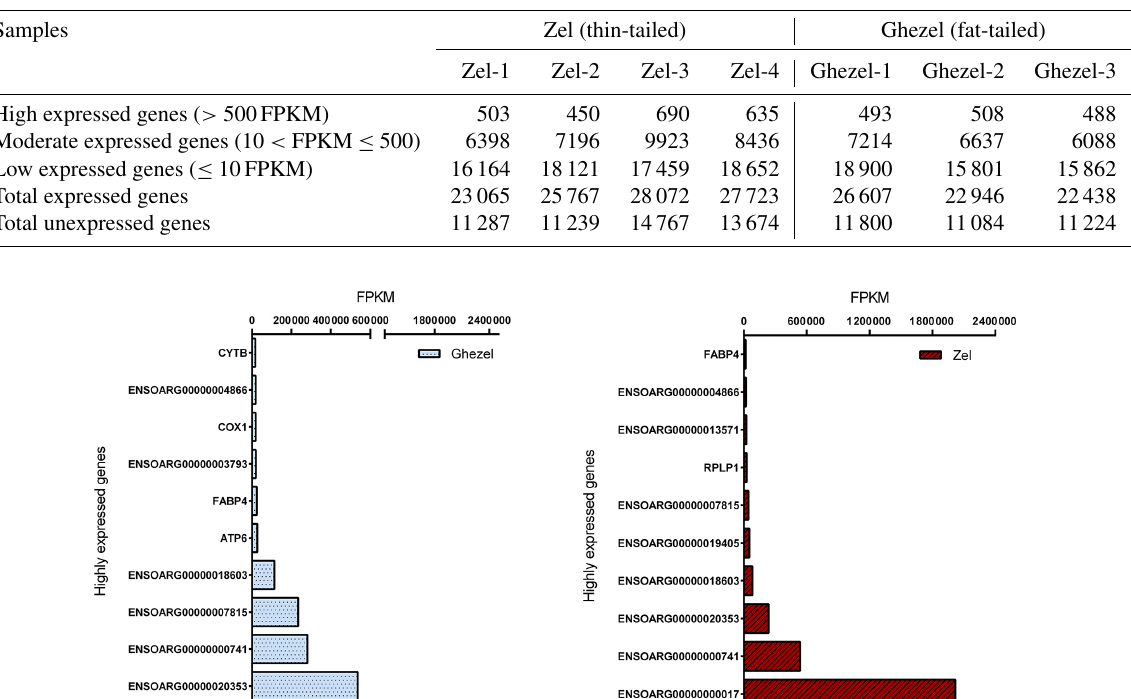
Table 2. Distribution of genes of different samples of Zel (thin-tailed) and Ghezel (fat-tailed) sheep breeds in three expression categories (high, moderate and low).